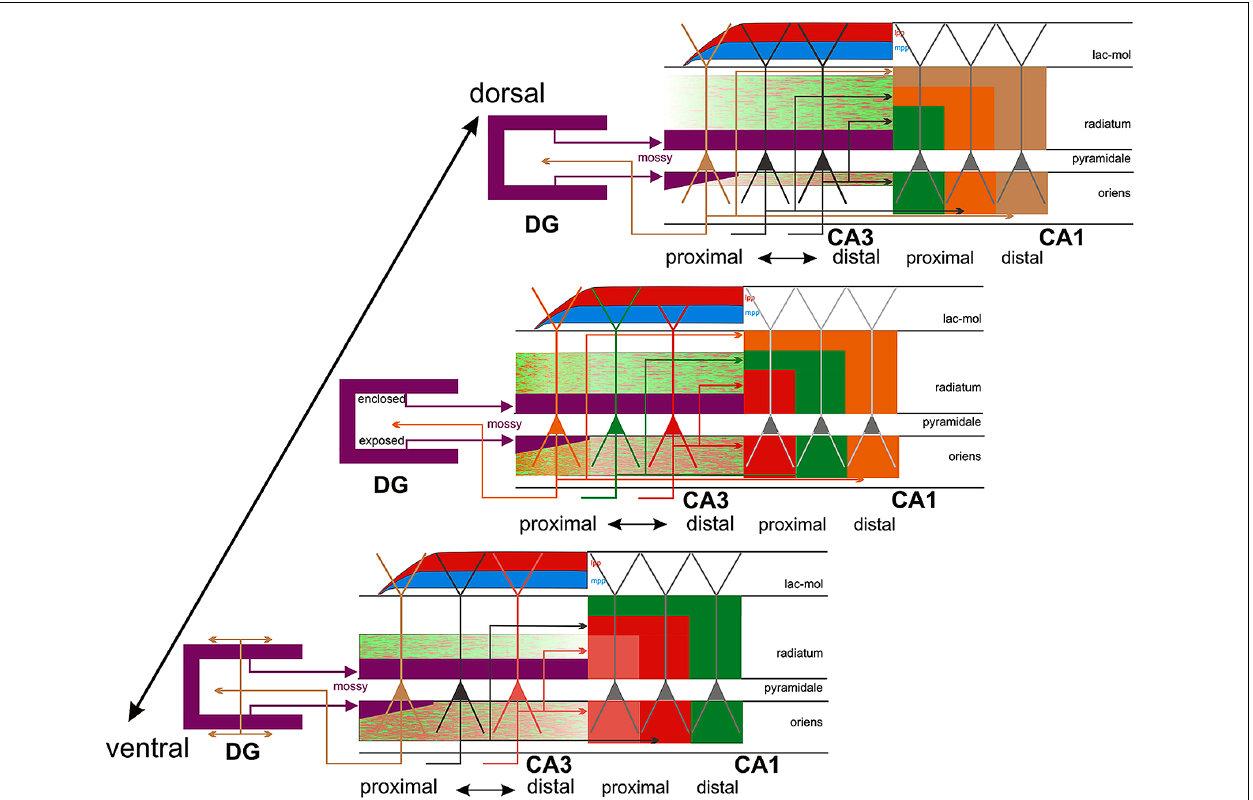
system (orange/green terminal field in radiatum and oriens at the level of the central panel only). This contrasts strongly with the more widespread distribution of the more distally arising components (green/red terminal fields in all three panels). Cells in proximal CA3, receiving less perforant path input (indicated by red and blue, lateral [lpp] and medial [mpp], respectively) but strong infrapyramidal mossy fiber input (purple), project back to the hilus of the dentate gyrus, with an increasing component that distributes to the inner molecular layer at more ventral levels (lower panel). Not indicated is the strong longitudinal component of the mossy fiber system that distributes along ∼ 20–25% of the long axis of distal CA3. Taken from Witter